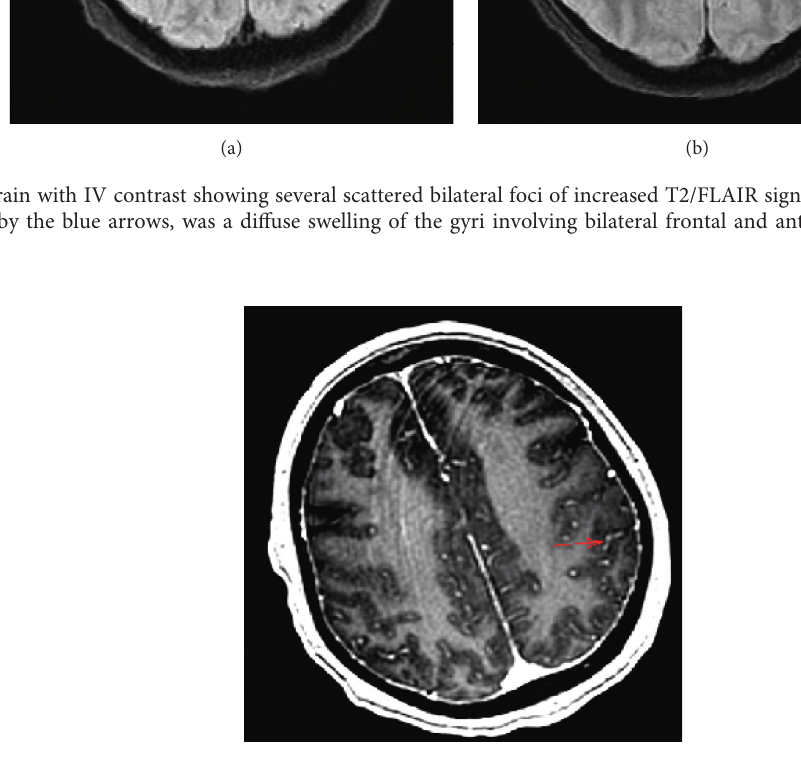
Figure 5: MRI brain with IV contrast suggesting sulcal enhancement of the gyrus representing underlying leptomeningeal disease.